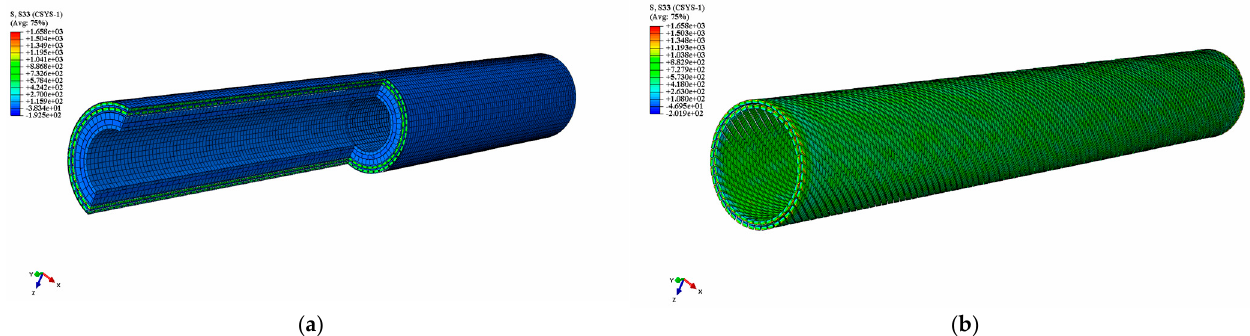
Figure 7. Axial stress nephogram of finite element model: ( a ) the overall of the riser; ( b ) tensile armor layers.